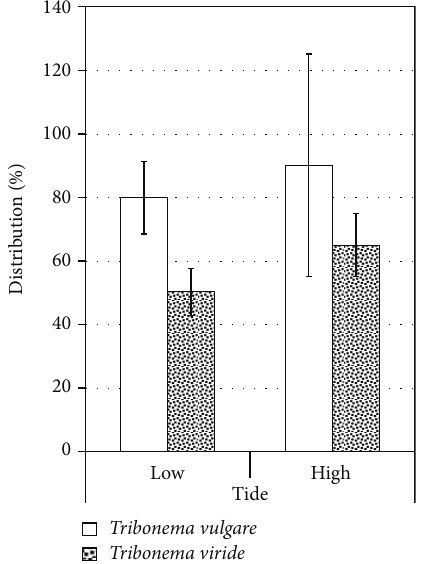
Figure 15: Variation of Xanthophyceae species in relation to tide in Okpoka